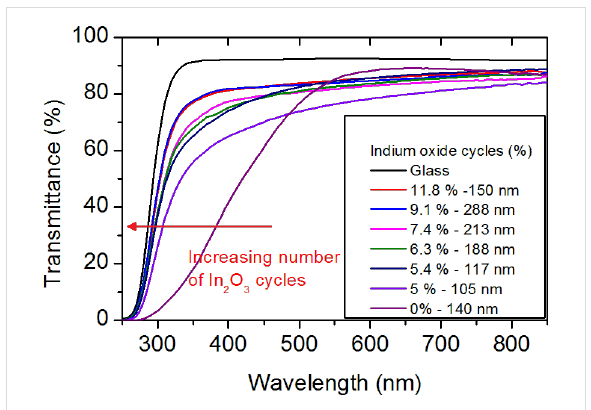
Figure 5: Influence of the number of In 2 O 3 cycle on the film transmit- tance when using O 2 plasma as oxygen precursor.